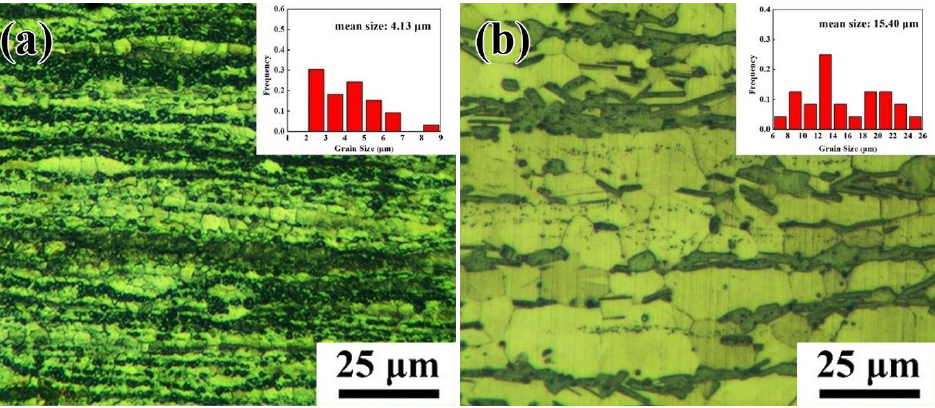
Figure 3. Optical microstructures of the Mg-11.46 Gd-4.08Y-2.09Zn-0.56Zr alloy under ( a ) T5 and ( b ) T6 states. Figure 4 indicates the SEM diagram and EDS analysis of the Mg-11.46 Gd-4.08Y-